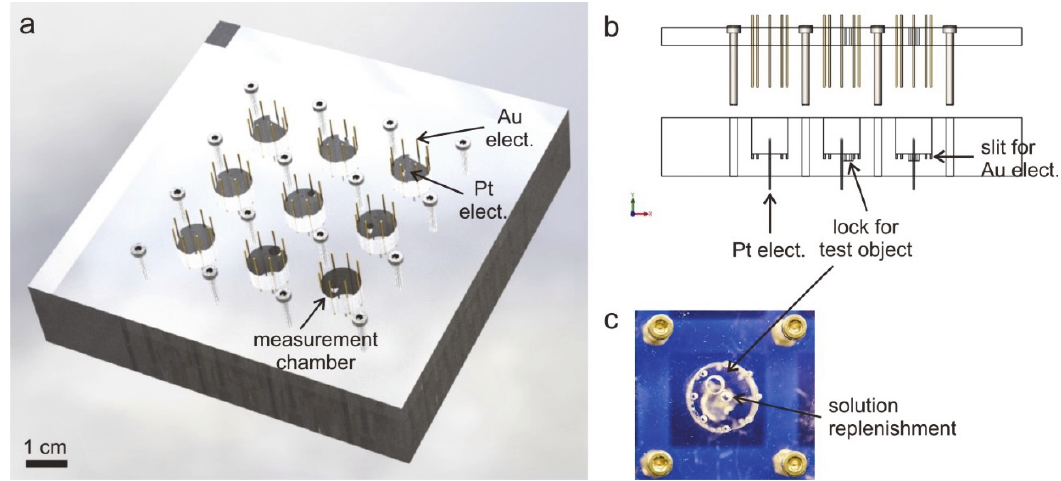
Fig. 1 (a): The measurement chamber array. Eight Au plated electrodes were placed at the periphery of each chamber. When present, the Pt electrode was placed at the centre of the chamber through the bottom plate (8+1 electrodes). (b) Schematic (side view) showing the Pt electrode, the circular slits for positioning the Au electrodes and micromilled depressions at the bottom of the chamber to keep the Au electrodes and the test object in position. (c) Photo of a measurement chamber. The lid had an opening to lock the test object in position and